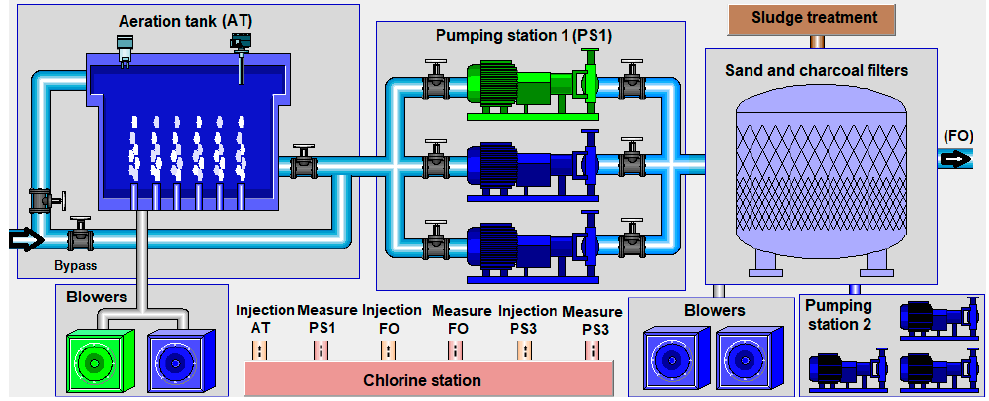
Figure 3. Main electrical parameters monitoring of the WTP and water distribution facility (WDF).